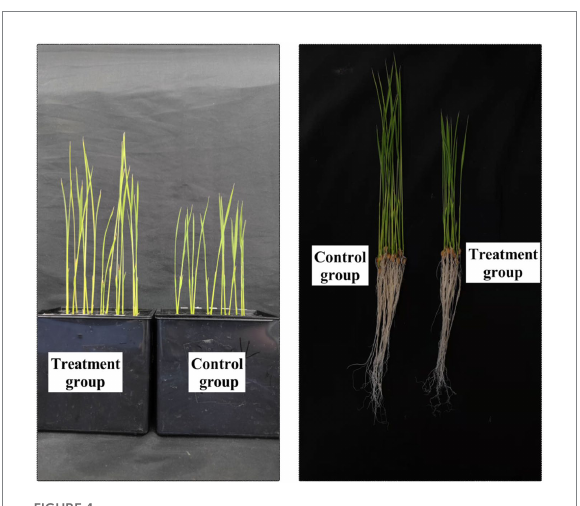
FIGURE 4 Effect of FYN-22 strain on the growth of rice